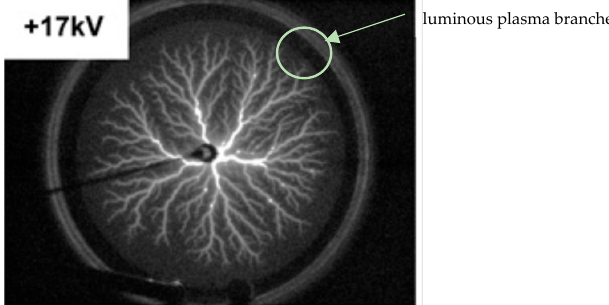
Figure 4. Surface discharge at the surface of insulator in SF6 with 3 bars under LI+ according to Reference [10].